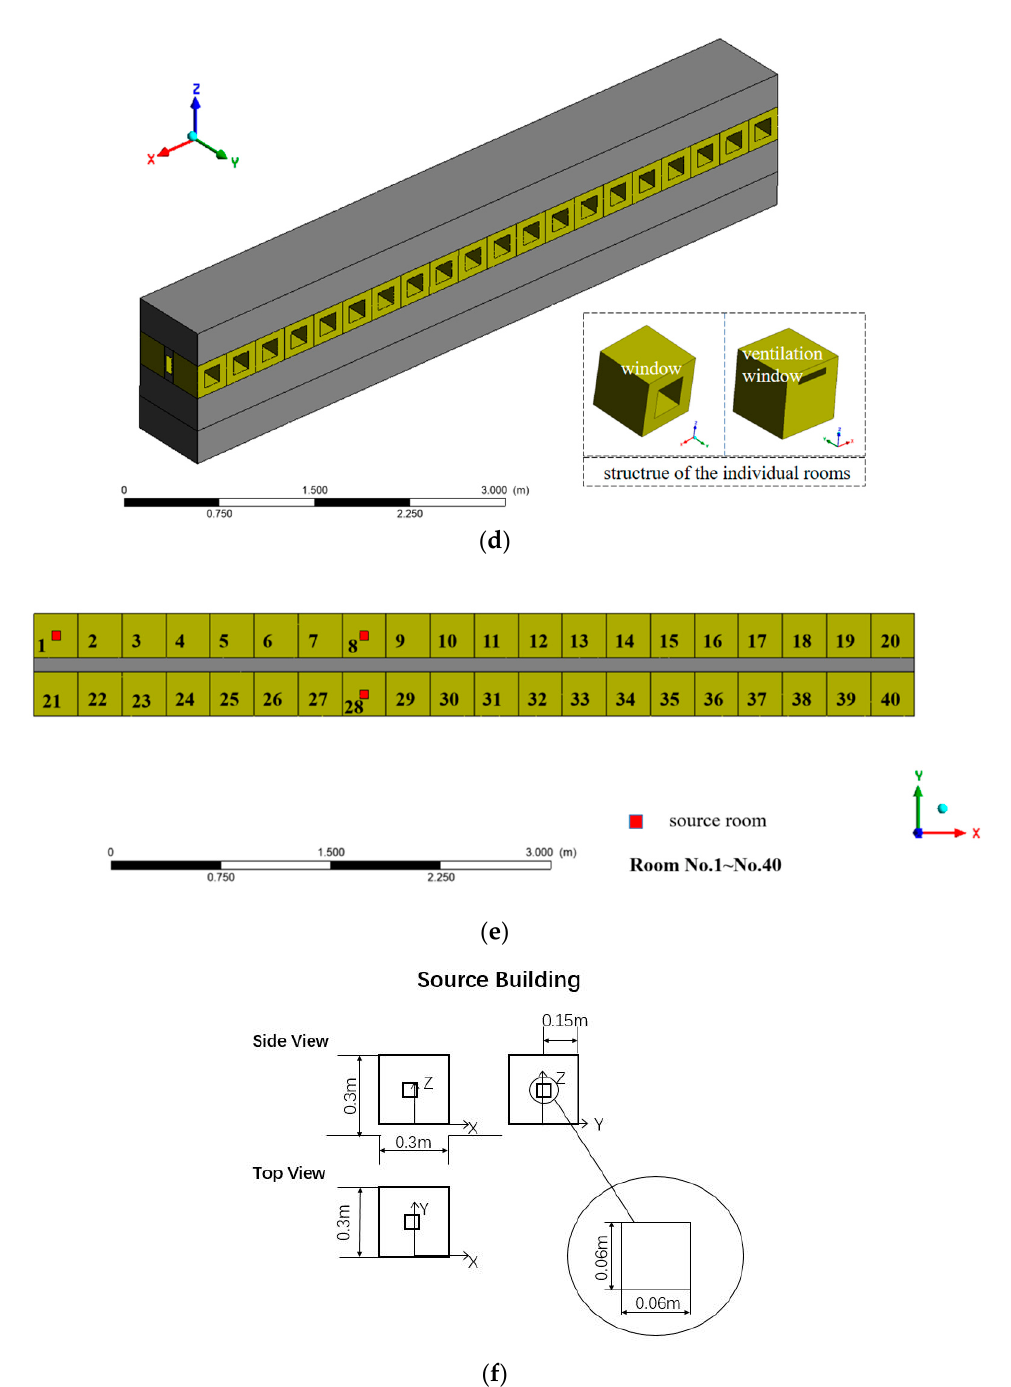
Figure 3. Building arrangements of dormitory complex. D: Dormitory building; Q: Quarantine area; R: Residential building. ( a ) Building layout near the dormitory complex location. ( b ) Schematic diagram of Q1. ( c ) Schematic diagram of D3. ( d ) Physical model of the third floor of D3. ( e ) Plan view of the third floor of D3. ( f ) Setting of the pollution source in the room.